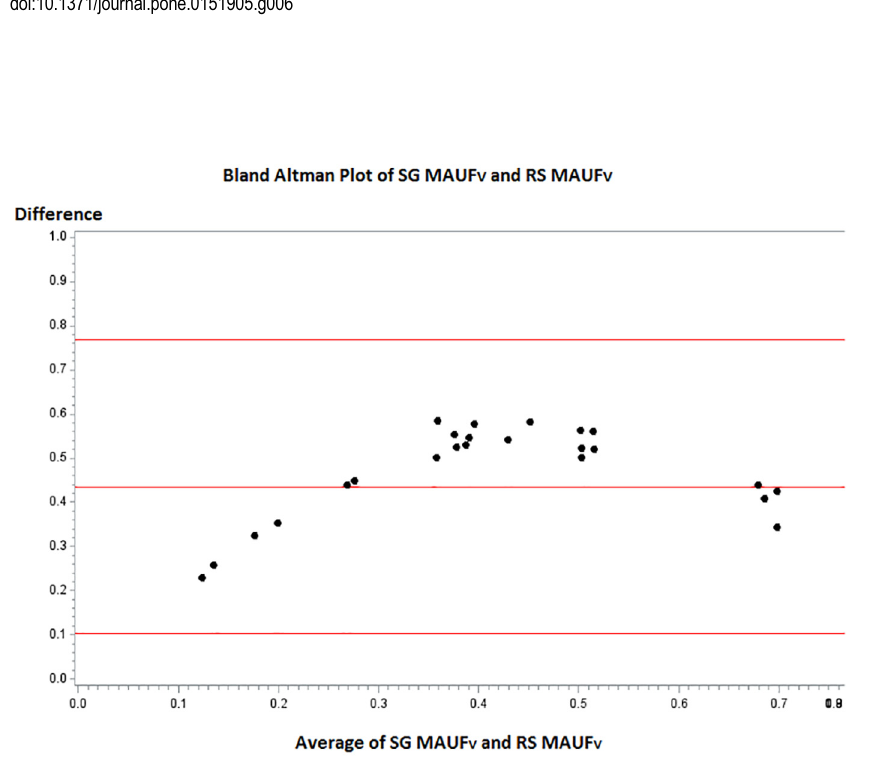
Fig 7. Bland-Altman plot to assess agreement between the SG MAUF V and the RS MAUF V in the validation sample.